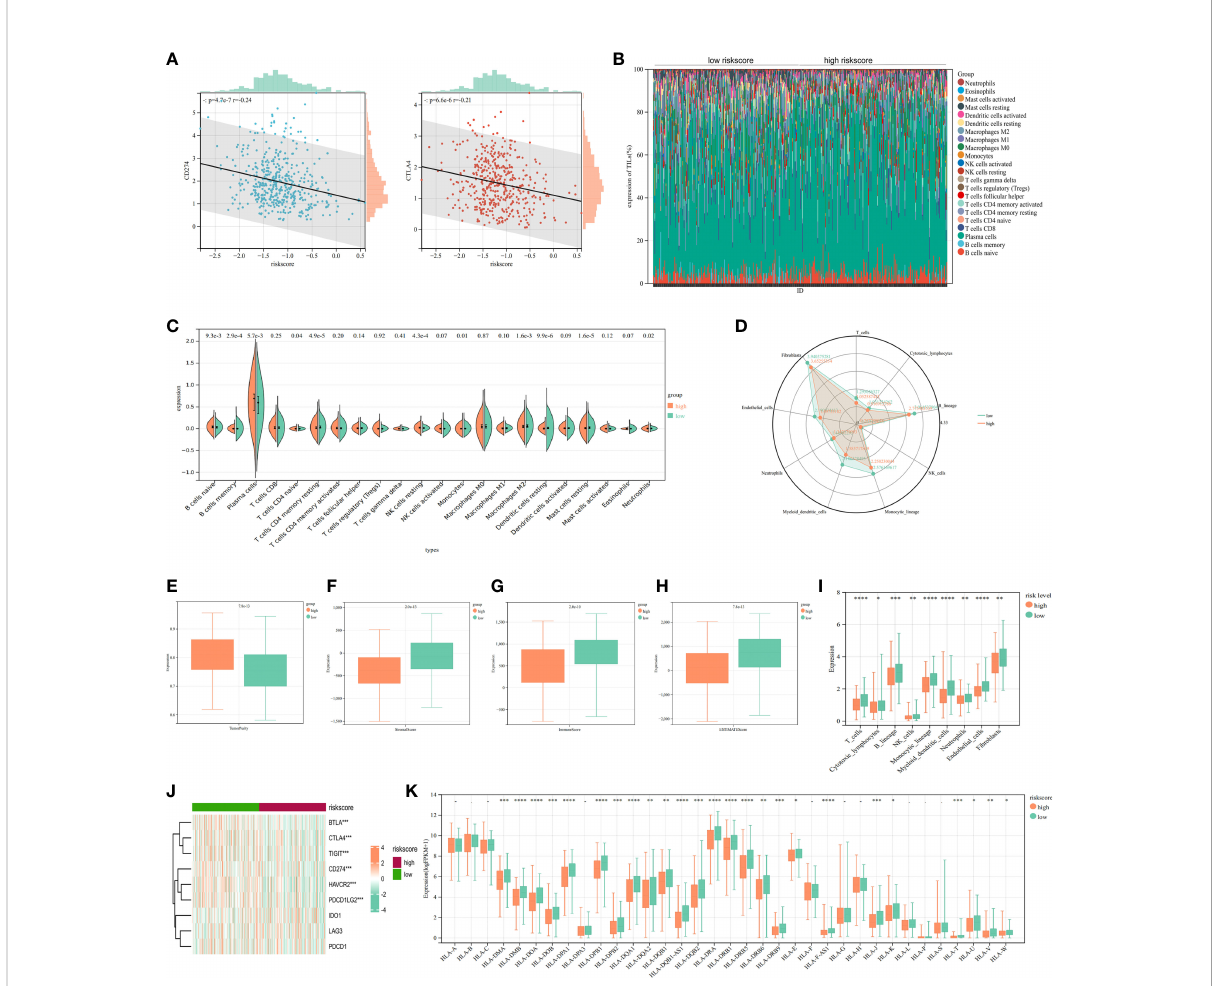
FIGURE 9 Immune in fi ltration analysis of signature. (A) The correlation analysis of PD-L1/CTL4 expression and riskscore distribution in LUAD. (B) The percentage abundance of tumor-in fi ltrating immune cells showed the immune in fi ltration analysis between high risk-score and low risk-score in LUAD patients. (C) The in fi ltrating levels of immune cells in high risk-score and low risk-score groups in LUAD patients. (D) Xcell algorithms detected immune cell expression between the high-risk and low-risk subtypes. (E-H) Comparison of ESTIMATE, stromal, and immune scores between the cluster 1 and cluster 2. (I) MCP-counter algorithm calculated the immune in fi ltrating cell score for each subgroups. (J) Comparison of immune checkpoints between high-risk and low-risk subgroups. (K) The HLA genes between high-risk and low-risk subtypes. * P <0.05, ** P <0.01, *** P <0.001, **** P